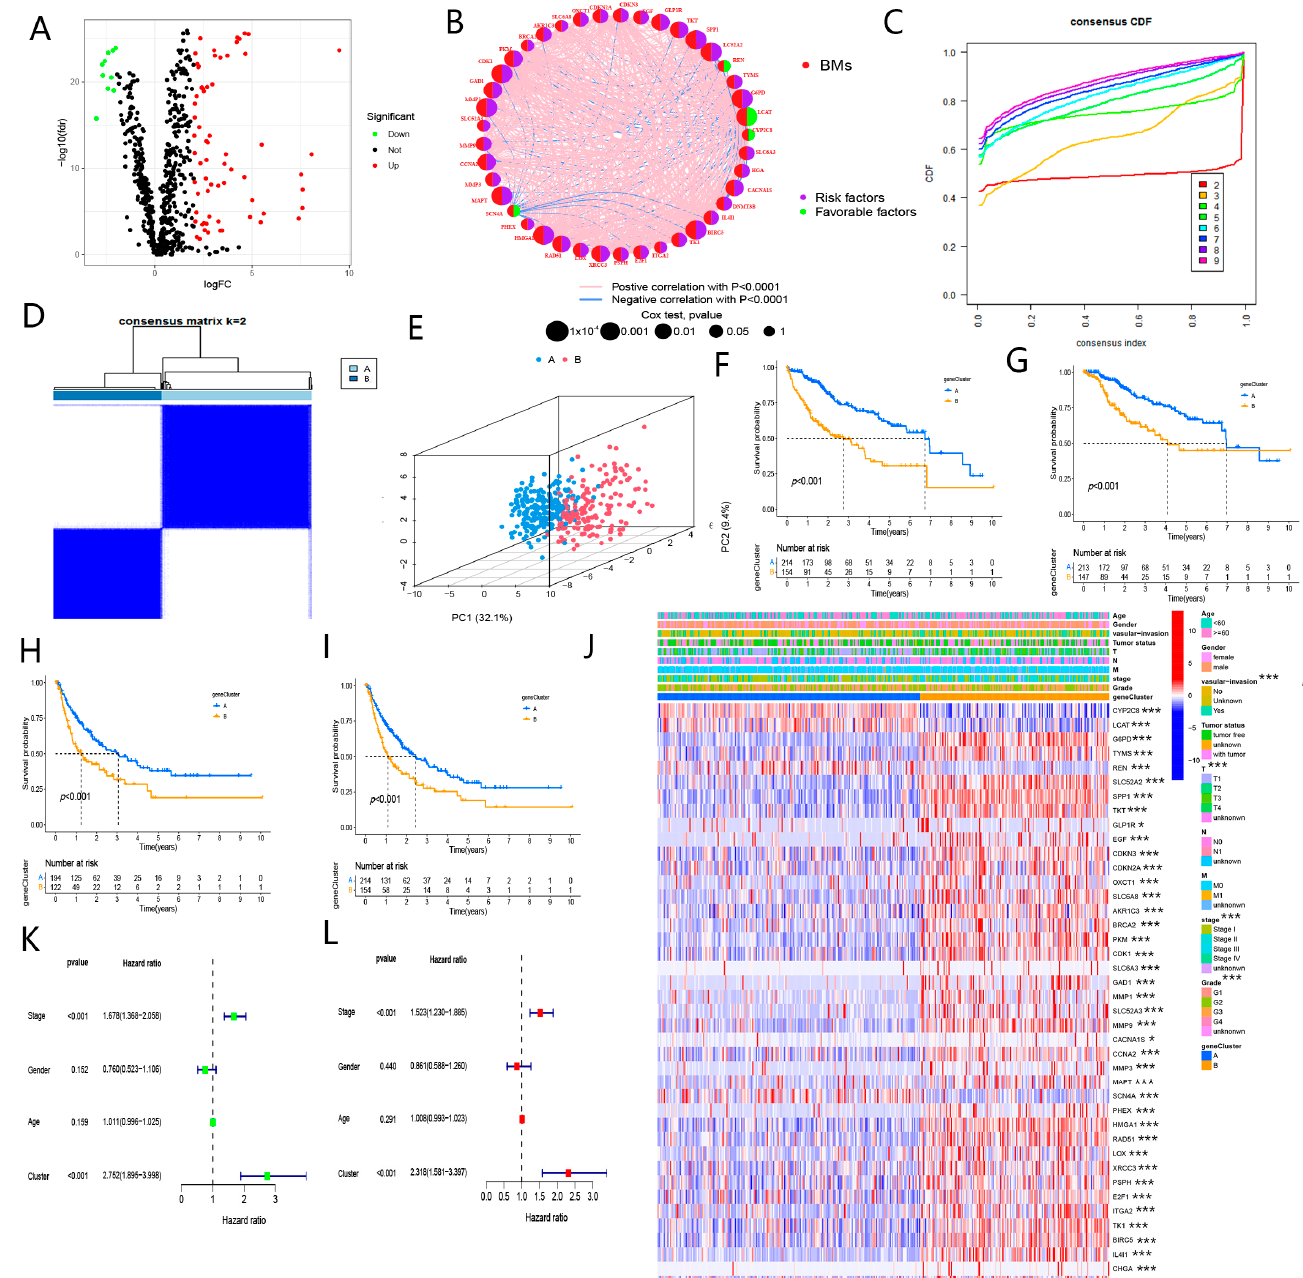
Figure 2. Consensus clustering of butyrate-related genes in HCC. ( A ) Differential expression analysis of butyrate metabolism-related genes in HCC tissues and normal tissues. ( B ) The correlation of candidate genes. ( C ) The consensus CDF value of patients with using unsupervised consensus clustering methods (K-means) in the TCGA-LIHC cohort. ( D ) The consensus matrix of patients with k = 2 using 1000 iterations of unsupervised consensus clustering methods (K-means) to ensure the stability of the clusters in the TCGA-LIHC cohort. ( E ) PCA analysis of distinct candidate butyrate clusters in the TCGA-LIHC cohort. ( F ) KM curves of overall survival (OS) for distinct clusters. ( G ) KM curves of disease-specific survival (DSS) for distinct clusters. ( H ) KM curves of disease-free interval (DFI) for distinct clusters. ( I ) KM curves of progression-free interval (PFI) for distinct clusters. ( J ) Complex heatmap showing the distribution of candidate butyrate genes and clinical features in A and B clusters. ( K ) Univariate Cox analysis of cluster, TNM-stage, age, and gender. ( L ) Multivariate Cox analysis of cluster and TNM-stage. (“*” and “***” represent p < 0.05, and p < 0.001, respectively).